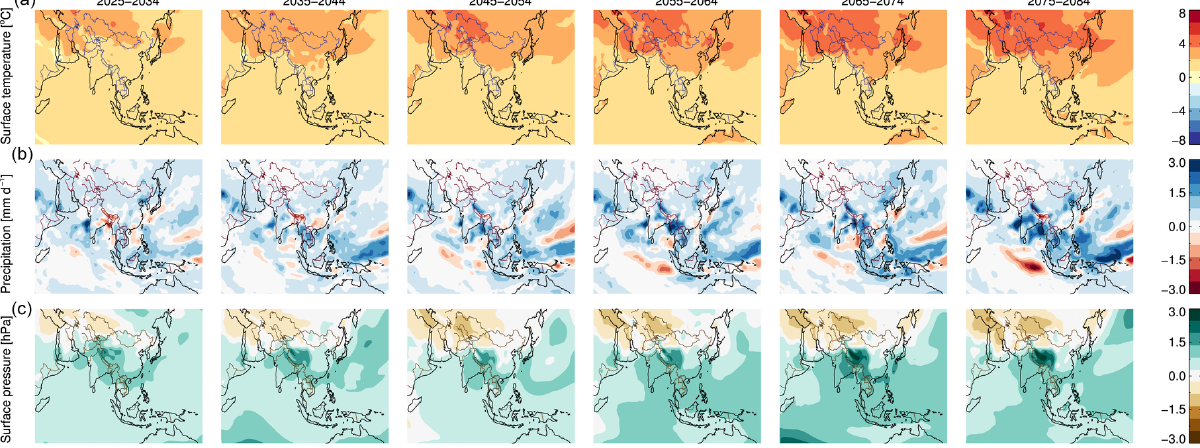
Figure 14. JJA-mean (a) near-surface temperature (K), (b) precipitation (mmd − 1 ), and (c) sea level pressure (hPa) anomalies for 10-year periods vs. 1980–2014 from SSP2-4.5 in